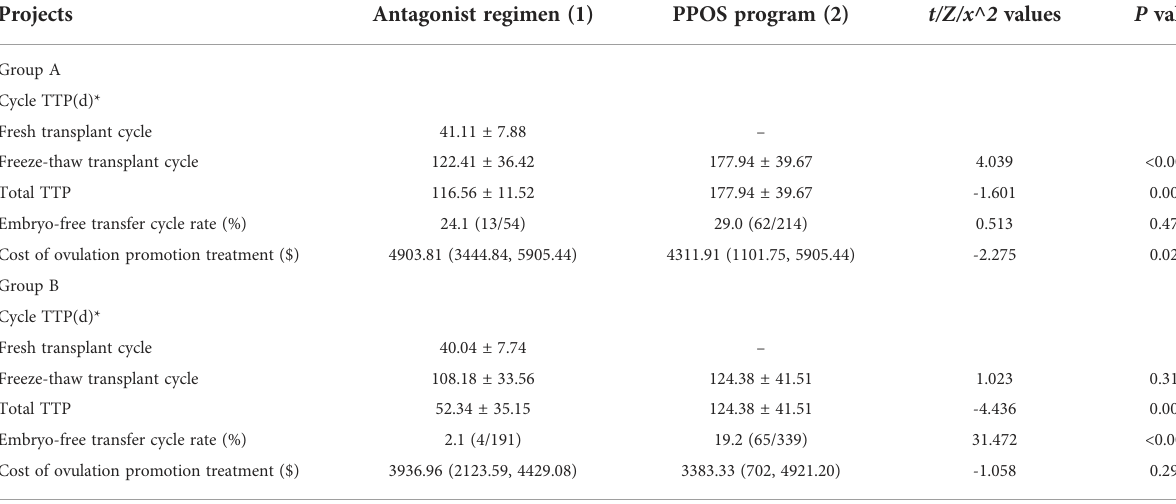
TABLE 6 Comparison of patient cost-effectiveness and TTP.